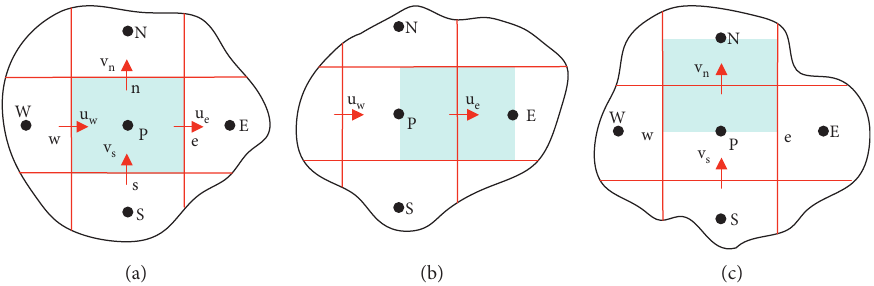
Figure 22: Control volume used to illustrate discretization of a scalar transport equation: (a) p-control volume, (b) u volume, (c) v s -control